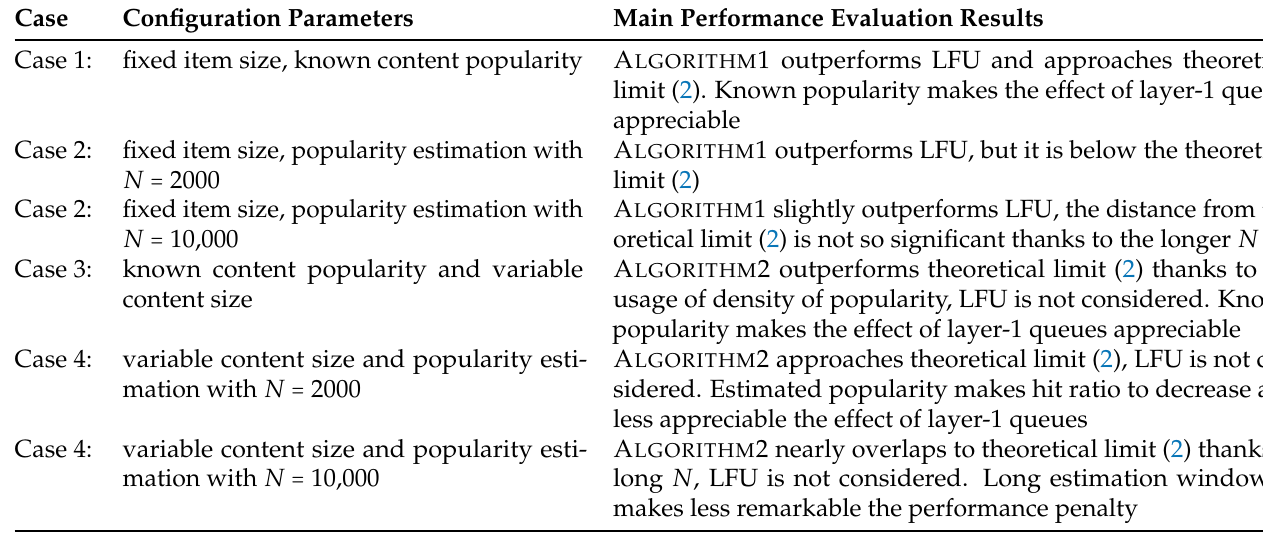
Figure 16. Fraction of hits at 1st layer caches, case 4, N = 10,000. Table 3. Summary of performance evaluation